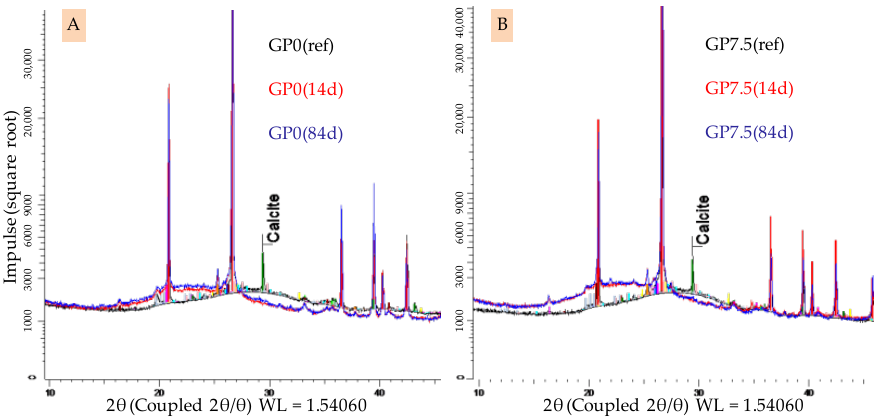
Figure 12. XRD spectra of geopolymers GP0 ( A ) and GP7.5 ( B ). Geopolymers before exposure to sulfuric acid (GP0(ref), GP7.5(ref)) and corroded layer after 14 days (GP0(14), GP7.5(14)) and 84 days of exposure (GP0(84), GP7.5(84)).